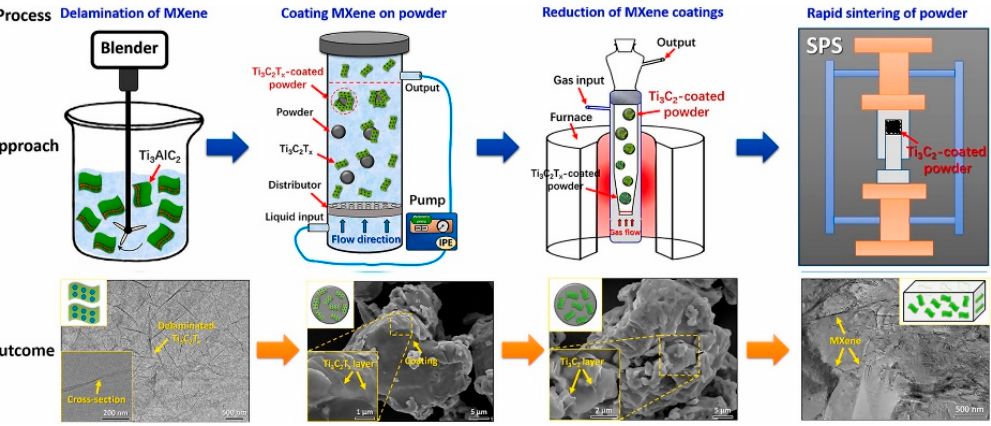
Figure 7. Schematic illustration of the powder metallurgy process. Reprinted with permission from Ref. [54]. 2020, Elsevier.